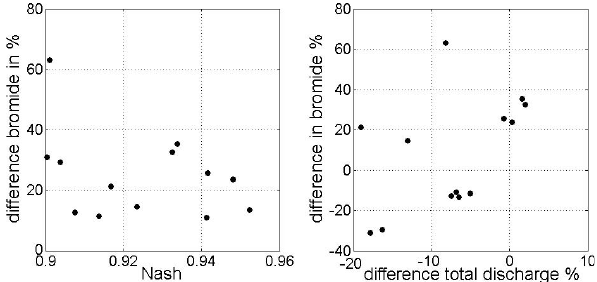
Fig. 10. Left panel: differences in bromide (observed to mod- elled) versus the Nash-Sutcliffe efficiency of the discharge mod- elling. Right panel: differences in total modelled bromide versus total observed bromide concentrations differences in total modelled to total observed